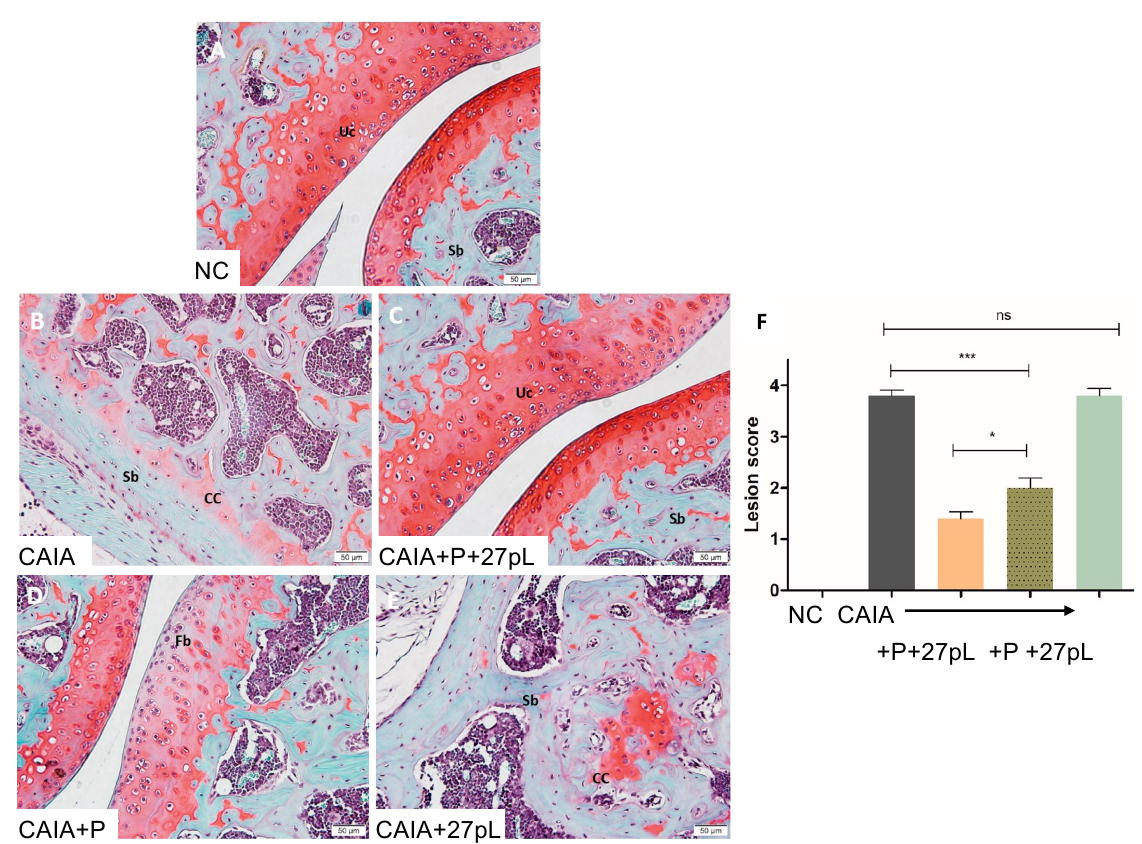
Figure 5. Histopathological analysis of articular cartilage erosion of knee joint. ( A ) Histological anal- ysis of no CAIA (NC) control animal knee joint stained with safranin ‘O’ showed normal uncalcified cartilage (Uc), and the subchondral bone (Sb). ( B ) Knee joint in CAIA mice (+ctrl) showed cartilage degradation extending up to the Sb and the presence of calcified cartilage (CC). ( C ) Treatment of the CAIA mice with P + 27pL showed Uc, and an absence of cartilage degradation or CC. ( D ) Treat- ment of the CAIA mice with P showed superficial fibrillation (Fb) of the articular cartilage. ( E ) Treat- ment of CAIA mice with 27pL showed degradation of cartilage and calcified cartilage and limited therapeutic effectiveness, as evidenced by Sb and CC abnormal morphology. ( F ) Total lesion score measurement indicated increased inflammatory lesions in the CAIA mice. Treatment with P showed a significant reduction in the lesion score of cartilage degradation and 27pL potentiated this effect. Results represent mean ± SEM. A one-way analysis of variance (ANOVA) followed by Tukey’s mul- tiple comparison t-test was used to calculate the statistical difference. The Mann–Whitney non- P + 27pL (* p ≤ 0.05; *** p < 0.001, with ns, not